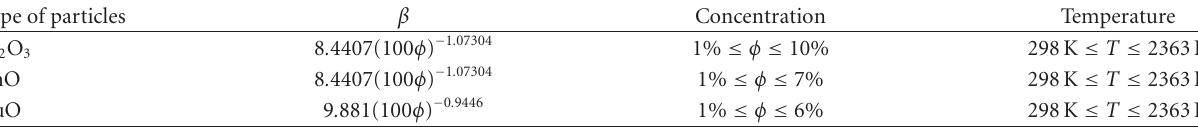
Table 2: β -Functions and Variable Ranges for Three Nanofluids, 60: 40 (by Mass) Ethylene Glycol and Water Mixture